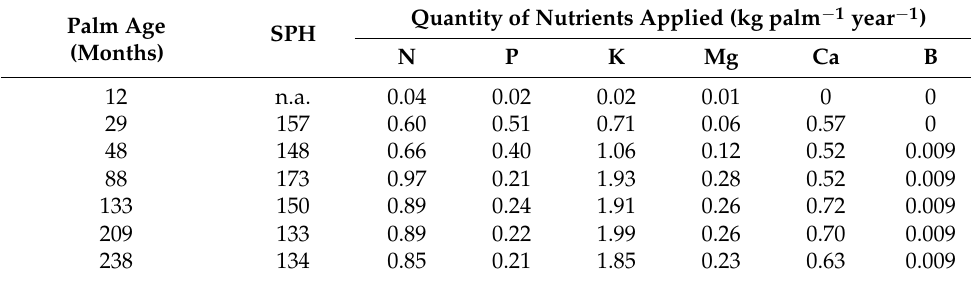
Table 1. Average fertilizer rates applied to the sampled tenera palms prior to destructive sampling. SPH and n.a. denote actual stands per hectare at time of sampling, and not applicable,